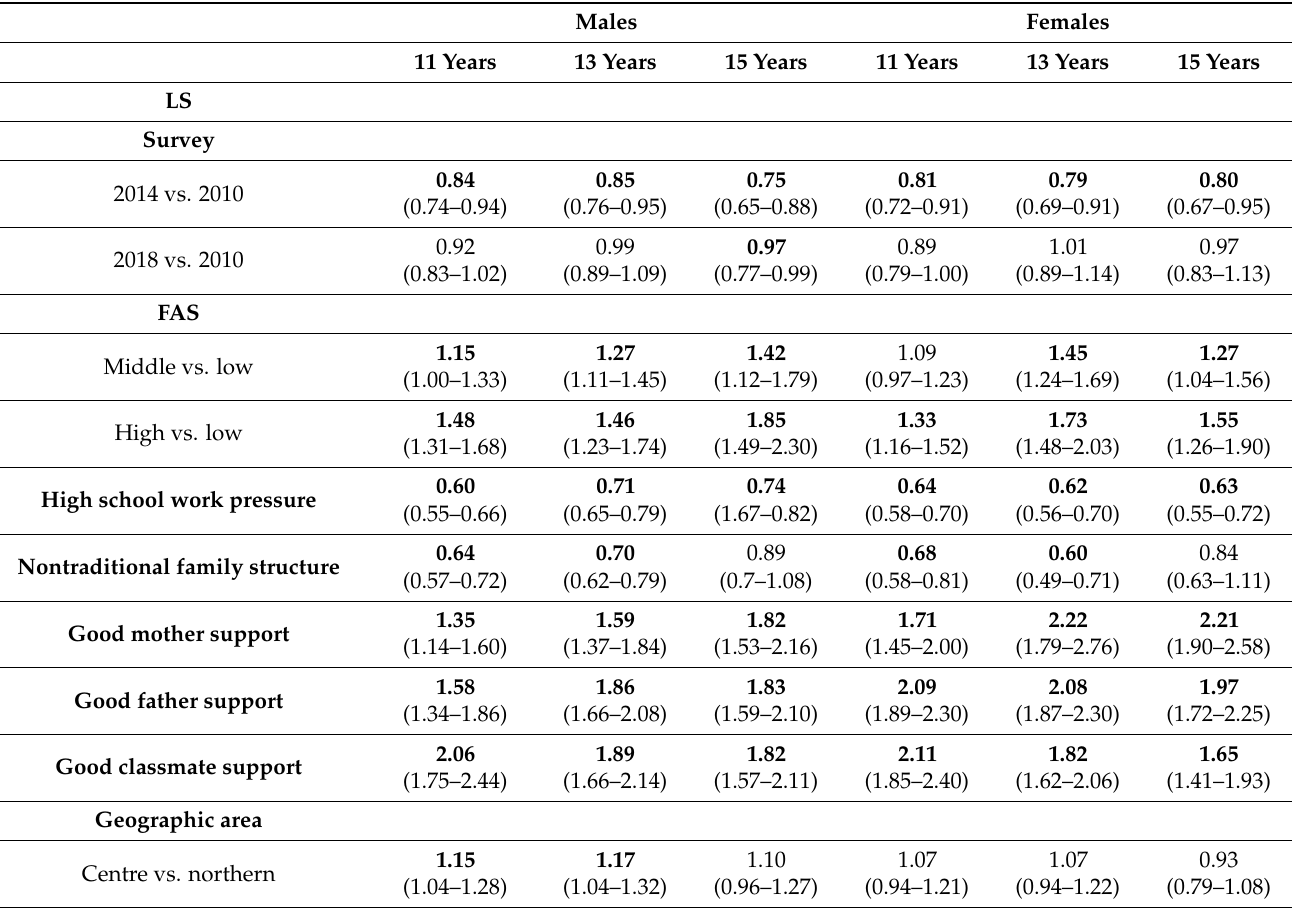
Table A4. Multivariable logistic regression (OR (95%CI)) predicting LS, HC, PSY-HC, and SOM-HC, stratified by gender and age